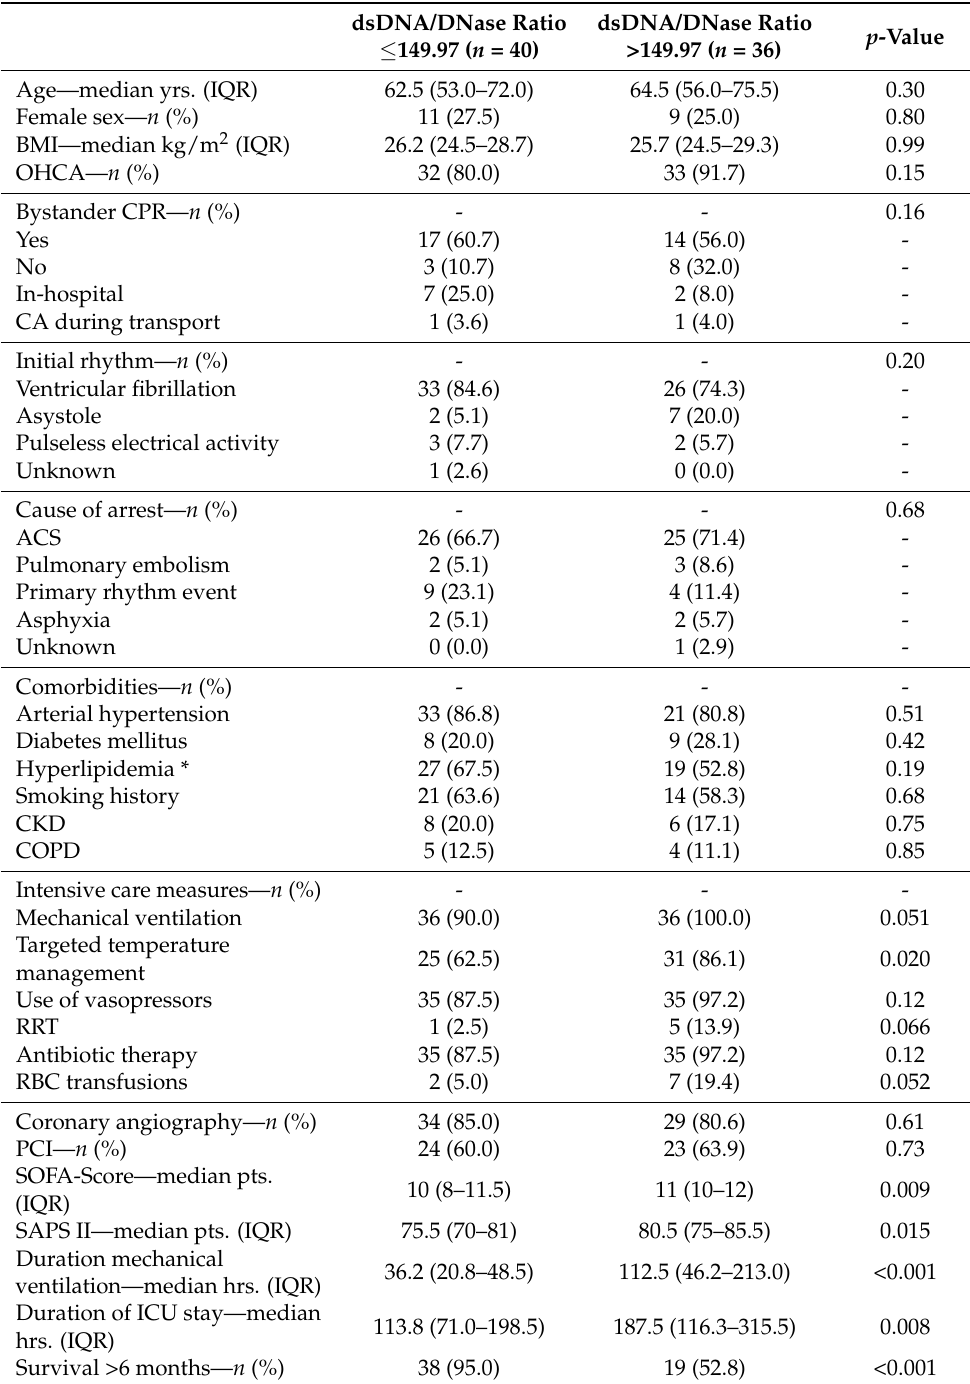
Table 3. Baseline characteristics, CPR-specific data, intensive care measures, and outcome data according to dsDNA/DNase ratio below and above the empirical cut-off